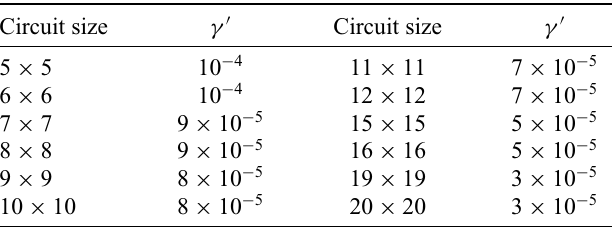
to zero with a finite number of samples due to a biased